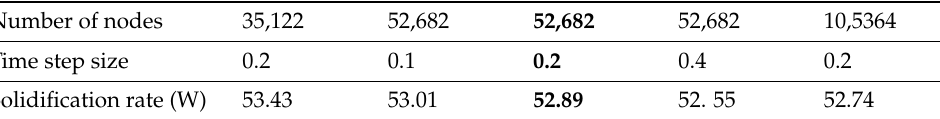
Table 2. The analysis of grid and time step sizes.